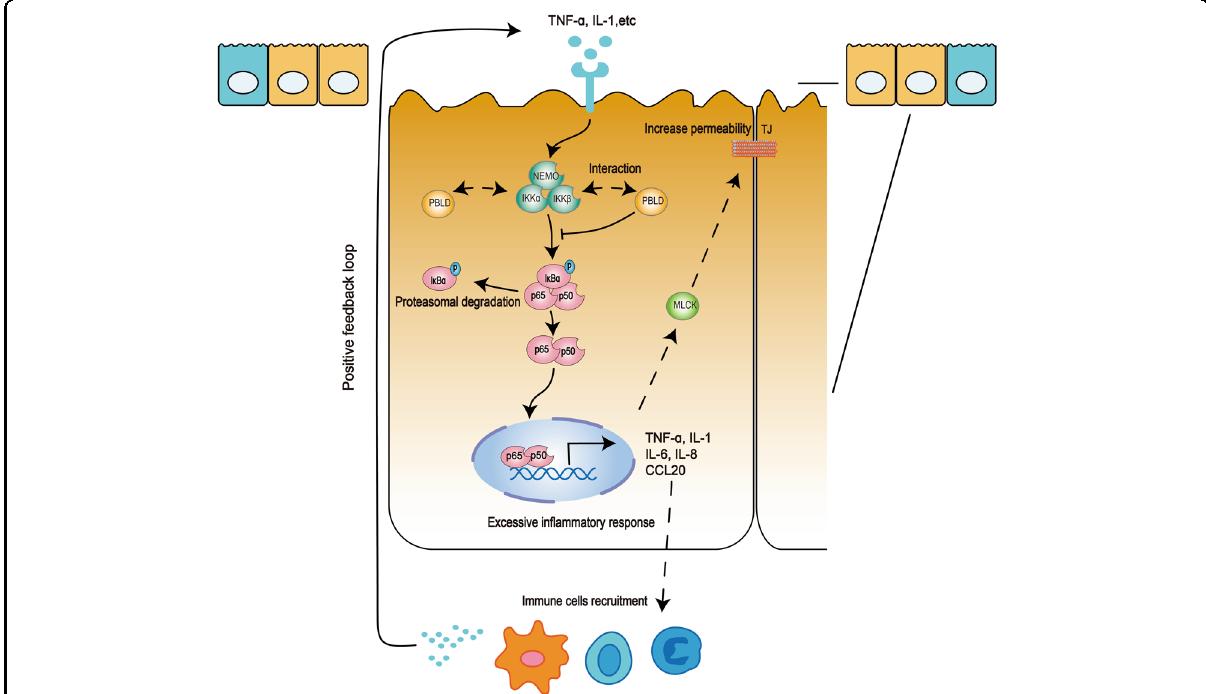
Fig. 8 Model of how PBLD regulates NF- κ B signaling pathway in the pathogenesis of UC. In response to microbial stimuli or cytokines, NF- κ B is activated in intestinal epithelial cells (IECs), which may impair epithelial barrier function and increase chemokine and cytokine production, resulting in the in fi ltration of more immune cells. When external stimuli persist, the recruited immune cells may produce more cytokines, leading to uncontrolled in fl ammation. PBLD may interact with IKK α and IKK β to prevent excessive in fl ammatory responses in IECs, thus attenuating intestinal mucosal in fl ammation and improving epithelial barrier